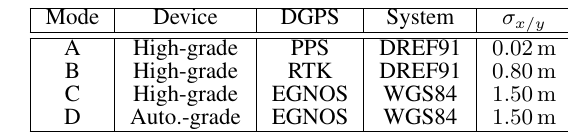
Table 2. GNSS devices installed in reference vehicle with DGPS services and specified accuracy. Figure 4. Map of test tracks with four scenarios (blue: calibration and rural, green: motorway, orange/red: urban area) and GNSS measured ground control (red) and check points (blue).